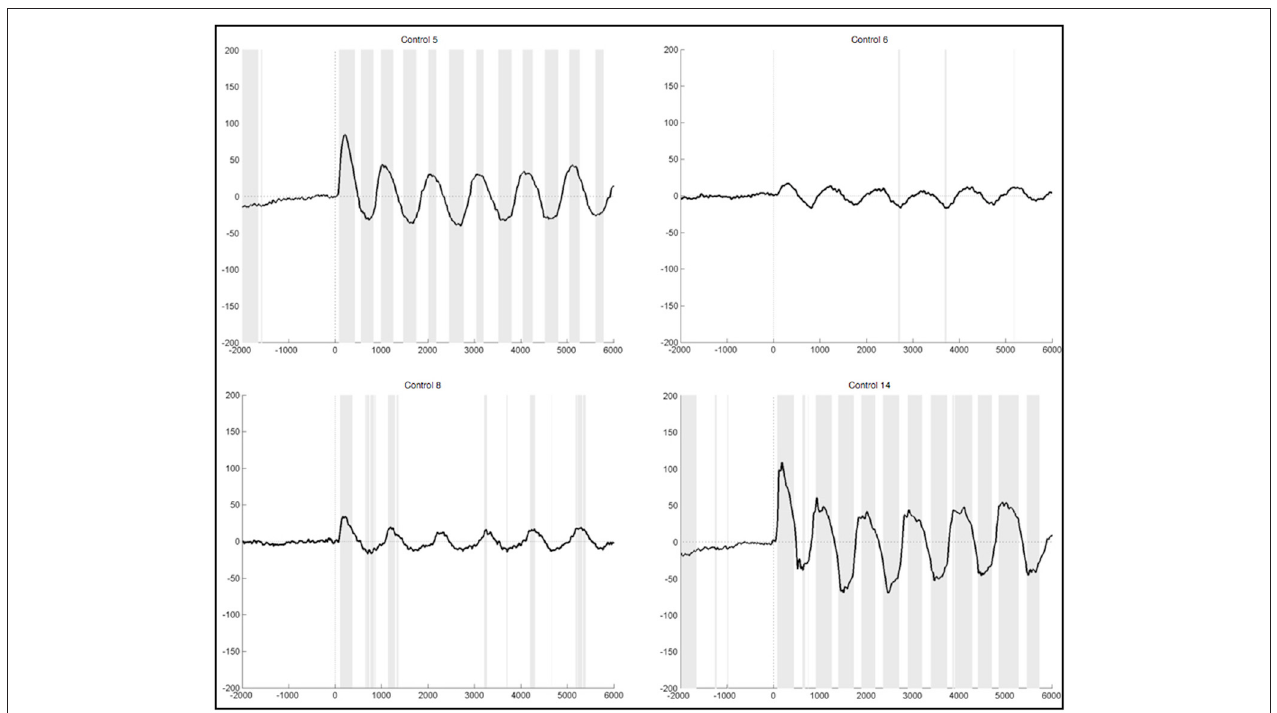
FIGURE 6 | Average ERPs of four healthy subjects after lenient exclusion recorded on Pz during foot movement execution. Segments are based on EMG onset (time point 0). The x-axis displays time (ms) and the y-axis amplitudes ( µ V). Sections shaded in gray indicate significant differences from the resting condition on a single trial level with p <